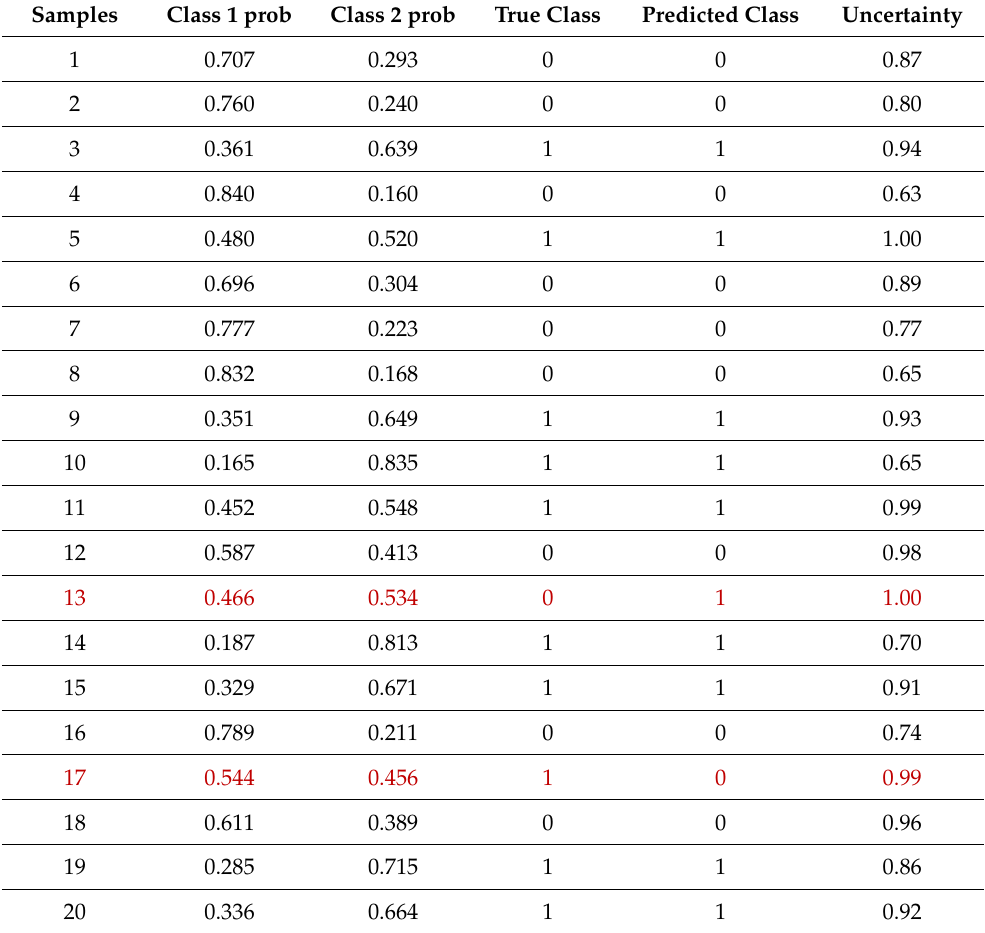
Table 4. Test predictions, prediction probability and uncertainty for GPR model with UMAP. The misclassified samples are highlighted in